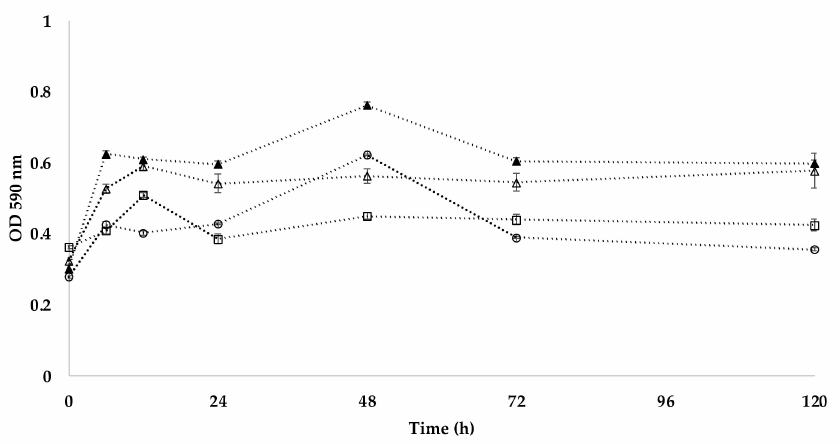
Figure 4. Substrate average well color development (AWCD) of Kocuria sp. isolate 101 ( 208 ( (cid:52) ), isolate 301 ( (cid:78) ), and isolate 401 ( (cid:3)